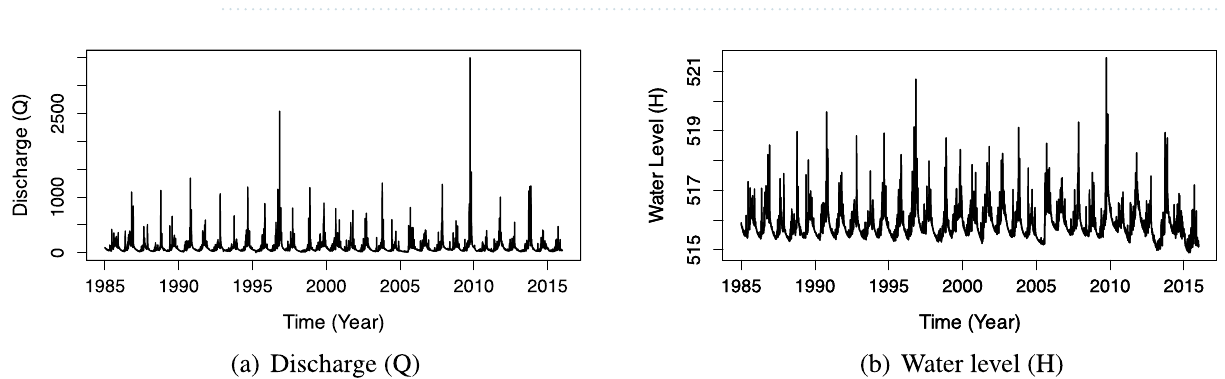
Figure 7. The visualization of the Son Tay dataset’s discharge and water level after removing noise and discontinuous data.